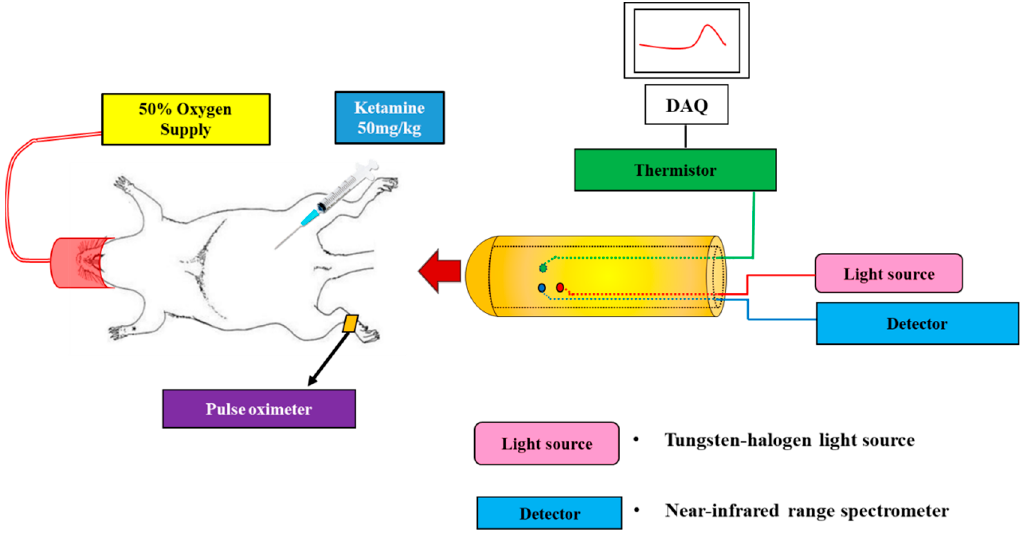
Figure 2. Experimental setup.